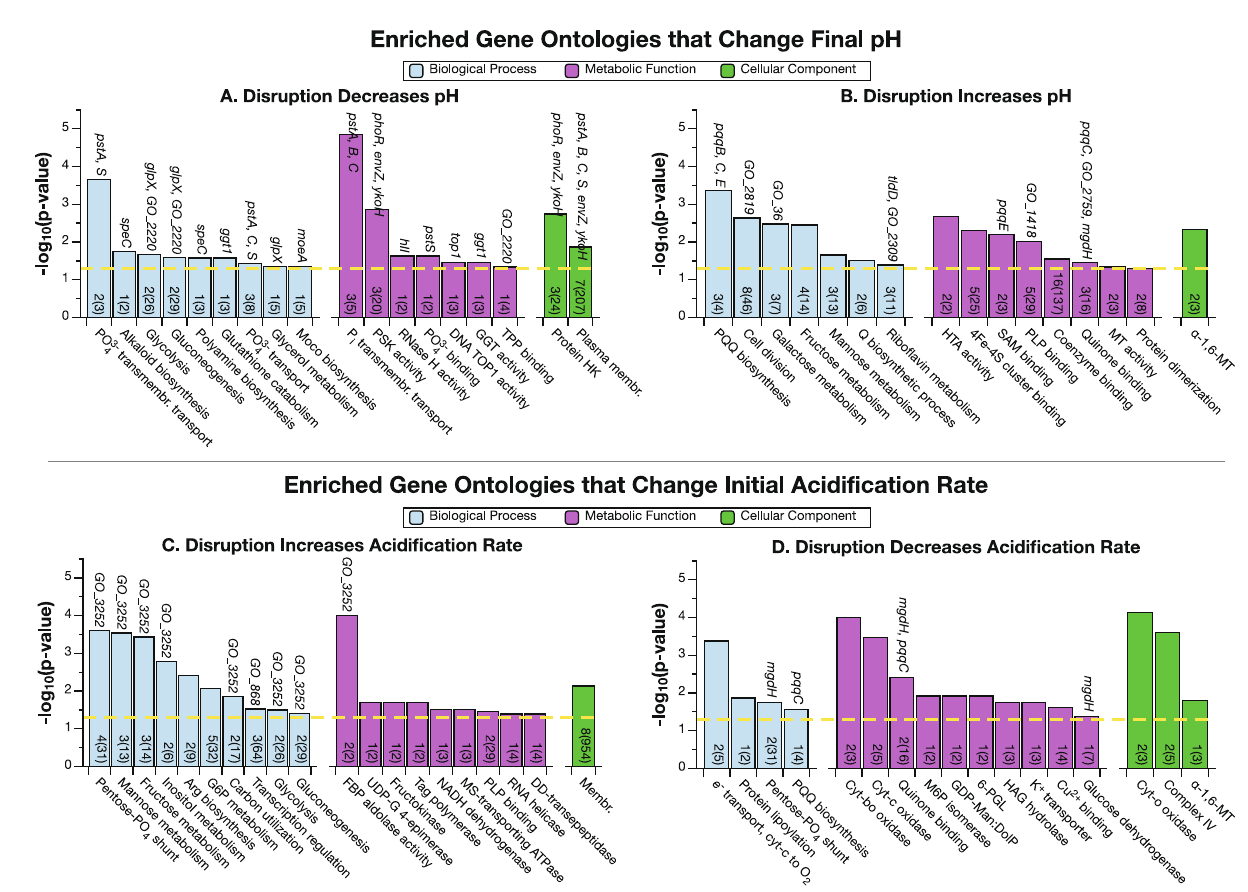
NATURE COMMUNICATIONS| (2021) 12:6693 |https://doi.org/10.1038/s41467-021-27047-4|www.nature.com/naturecommunications